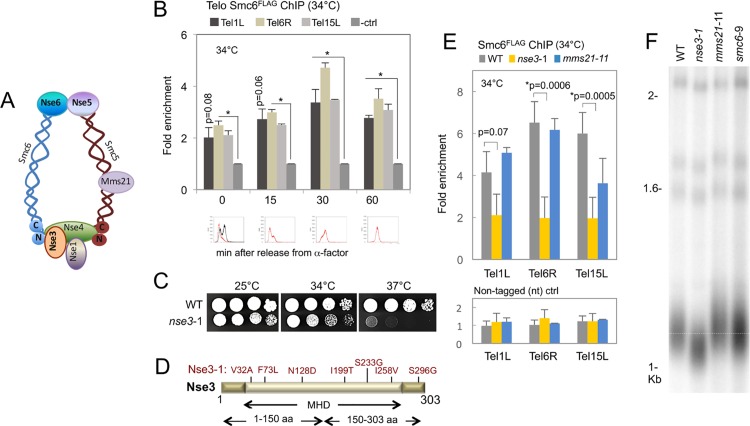
Smc5/6 is a telomere binding complex.(A) A schematic representation of the Smc5/6 complex showing the location of Nse3 as part of a trimeric sub-complex located at the head region where Smc5 and Smc6 meet. (B) Chromatin immunoprecipitation (ChIP) followed by qPCR was performed on Smc6FLAG (JC1594) at the indicated time points after release from α-factor. The fold enrichment at three native subtelomeres (Tel1L, Tel6R and Tel15L) compared to a control (ctrl) late replicating region on Chromosome V (469104–469177) is reported with the mean ± SD for n≥3 experiments performed in technical duplicate. (*) Indicates a statistically significant level of enrichment compared to the ctrl with p values < .05 by a two-tailed t-test. Smc6FLAG enrichment at Tel1L is higher at 0 and 15 minutes after release, but with p values = 0.08 and p = 0.06 respectively. The lower panels show flow cytometry on ChIP samples with an asynchronous culture shown in black at the 0 time point. (C) Drop assay of exponentially growing wild type (JC470) and nse3-1 (JC3607) cells that were grown for 48 hours at the indicated temperatures on YPAD and 1:5 serial dilutions. (D) Schematic diagram of Nse3. “MHD” represents Melanoma Homology Domain in Nse3 protein. Seven amino acid substitutions in Nse3-1 are shown in red. (E) Chromatin immunoprecipitation (ChIP) on Smc6FLAG in wild type (JC1594), nse3-1 (JC2630), mms21-11 (JC2075) and the non-tagged (nt) control strains for wild type (JC470), nse3-1 (JC3607), and mms21-11 (JC1879) in asynchronous cultures. The fold enrichment levels are relative to the late-replicating control region on Chr V for n = 3 experiments with the mean ± SD. All primers are listed in S2 Table. Enrichment levels for wild type and mutant cells with p values < .05 from a two-tailed t-test are indicated by (*). (F) Telomere length was determined as previously described [15]. Southern blot analysis was performed on 1μg XhoI-digested genomic DNA hybridized with a radiolabeled poly (GT/CA) probe in wild type (JC471), nse3-1 (JC3032), mms21-11 (JC1981), and smc6-9 (JC1358).In higher eukaryotes, telomeres are challenged by the continuous loss of DNA due to the end replication problem. However, in Saccharomyces cerevisiae, telomere length is maintained by the continued expression of telomerase, an enzyme containing a RNA subunit that serves as a template for de novo telomere synthesis [16]. After the 3’ end is extended by telomerase, the replicative DNA polymerase fills in the complementary strand. Both telomerase extension and semiconservative replication at telomeres are included in the final events of S phase (for review see [17]). In the absence of telomerase activity, telomeres shorten extensively, leading to senescence, however a small percentage of cells survive by extending their telomeres through the HR dependent alternative lengthening of telomeres (ALT) pathway [18–21].